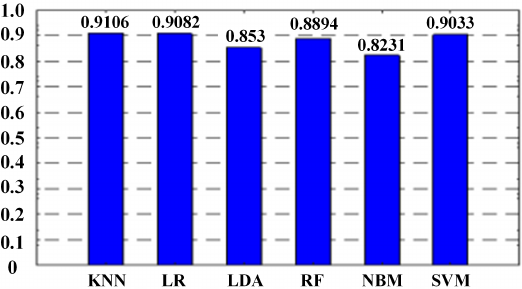
Figure 16. Comparison of recognition rates of different classification algorithms.